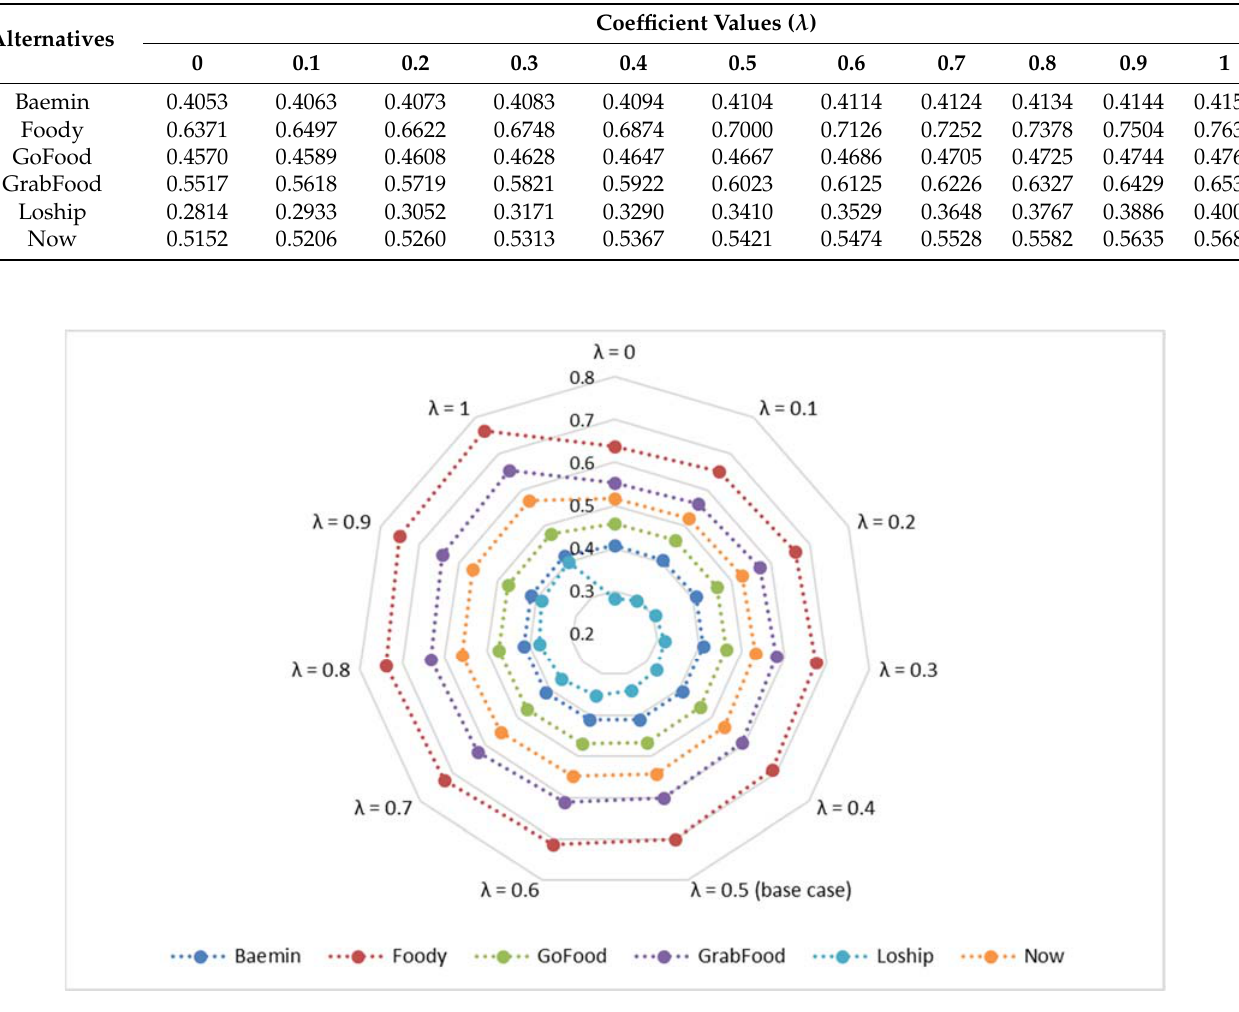
Figure 6. The sensitivity analysis to change in the trade-off parameter λ